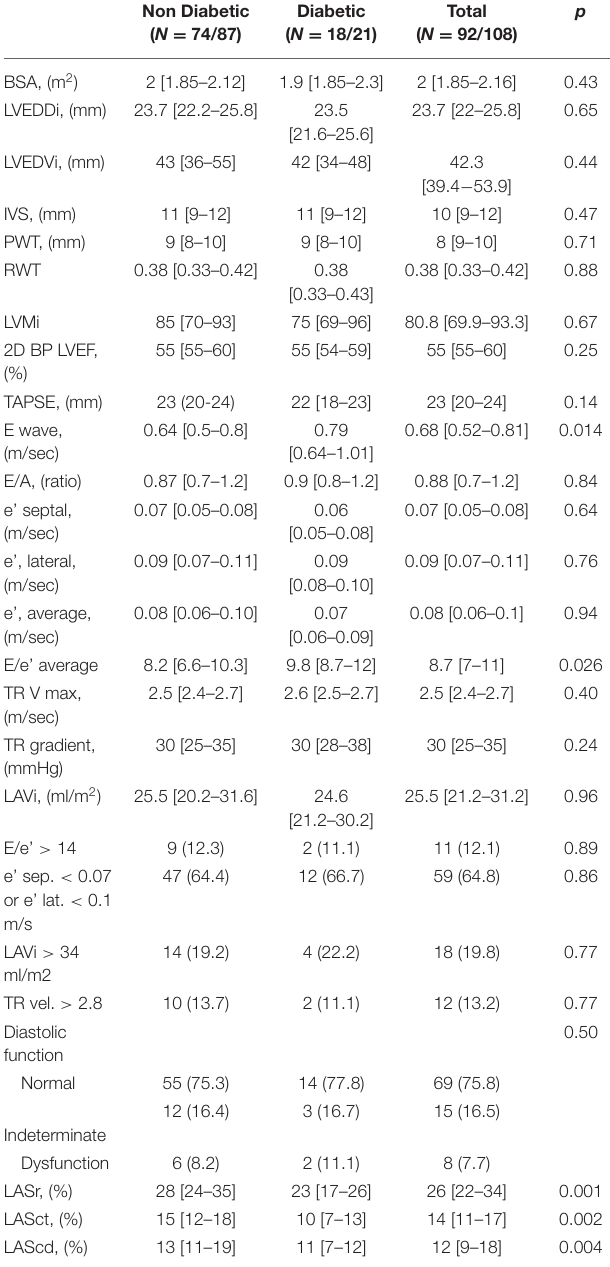
Continuous variables are presented as median (IQR); categorical ones as n (%). LVEDD, left ventricular end-diastolic diameter indexed to BSA; LVEDVi, left ventricular end-diastolic volume indexed to BSA; IVS, interventricular septum; PWT, posterior wall thickness; LVMi, left ventricular mass indexed to BSA; 2D LVEF, two-dimensional left ventricular ejection fraction; TAPSE, tricuspid annular plane systolic excursion; TR, tricuspid regurgitation; LAVi, left atrium volume index. LASr, left atrial reservoir strain; LASct, left atrial contraction strain; LAScd, left atrial conduit